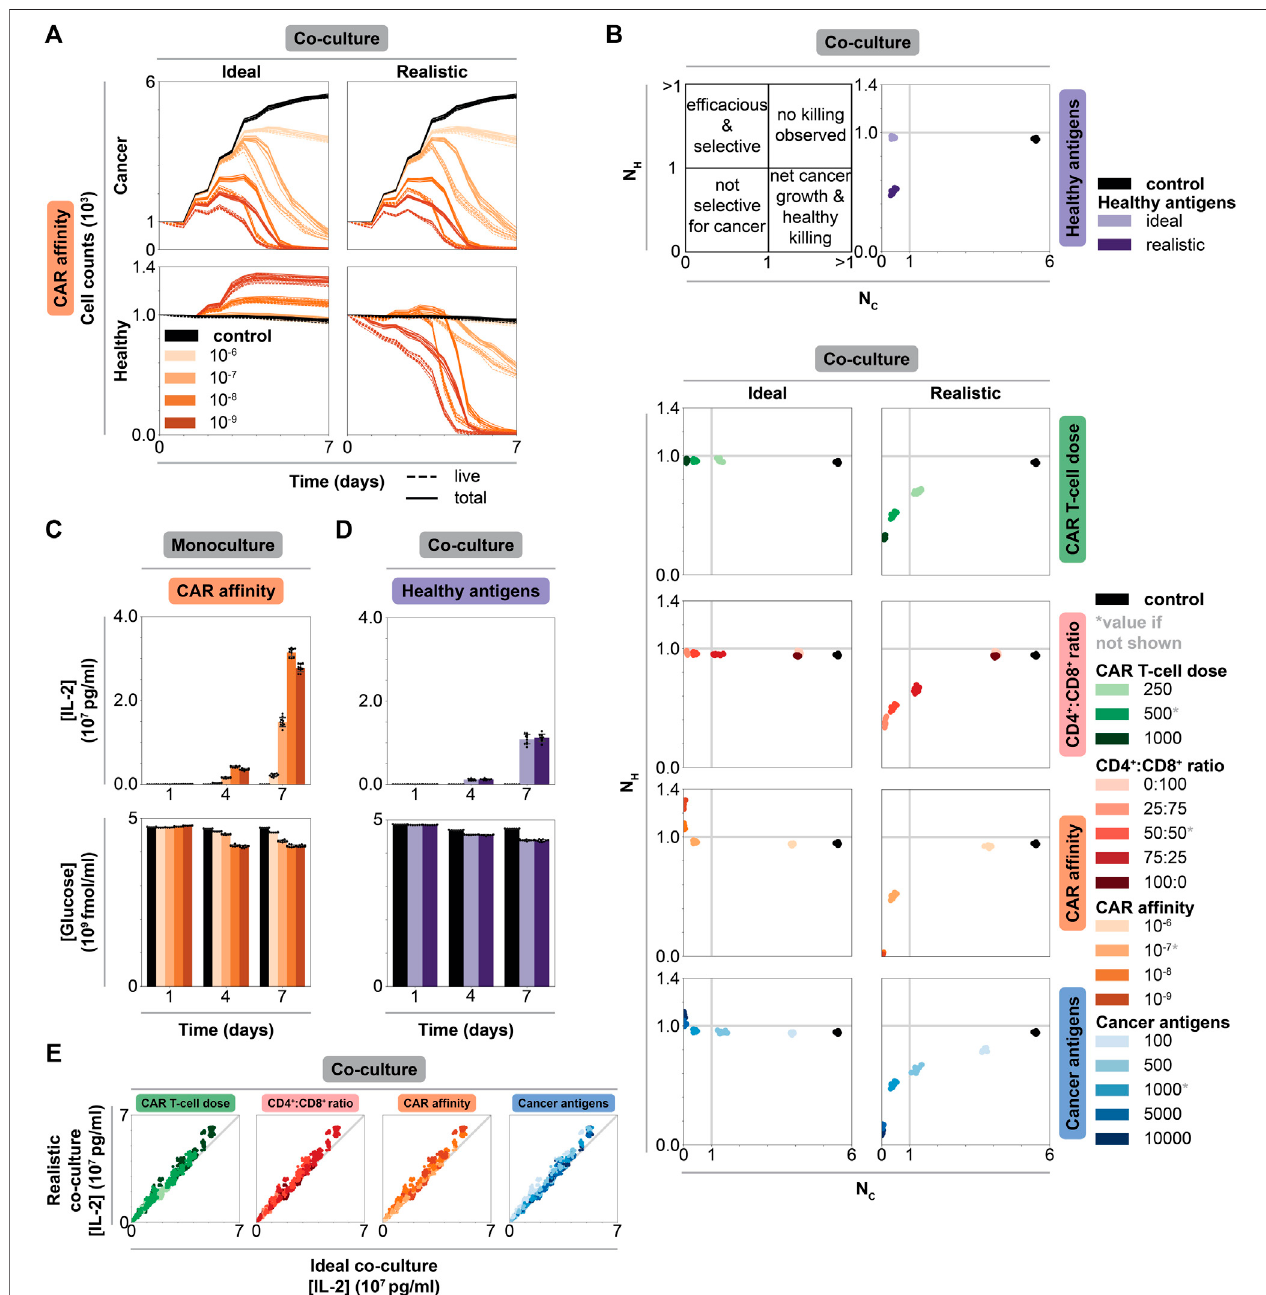
FIGURE 3 | Impact of individual CAR T-cell and tumor features on ef fi cacy, selectivity, and cytokine production in monoculture vs co-culture. (A) Cancer and healthy cell counts over time of untreated (black) and treated (graded hues) conditions holding all but CAR af fi nity, which is reported in units of M, constant at an intermediate value and separating data by co-culture context. Column shows co-culture type, row shows cell type. Solid lines represent total cell counts, dashed lines represent live cell counts (live, excludes necrotic and apoptotic states as in Figure 2 ). Intermediate values of other features indicated by asterisk in panel B: CAR T-cell dose = 500 CAR T-cells, CD4 + :CD8 + ratio = 50:50, cancer antigens = 1000 antigens/cell. (B) Scatter plots of normalized live healthy cell count ( N H ) vs normalized live cancer cell count ( N C ) for untreated (black) and treated conditions (graded hues) holding all but one axis constant at an intermediate value. Upper left plot shows quadrant meanings. Upper right plot shows scatter plot for different co-culture contexts. Columns show co-culture type, and each row indicates which feature is being plotted. (C) IL-2 and glucose concentrations over time holding all but CAR af fi nity constant at an intermediate value in monoculture. Legend is consistent with panel B. (D) IL-2 and glucose concentrations over time varying CAR af fi nity while holding all features constant at an intermediate value in ideal and realistic co-culture. Legend is consistent with panel B. (E) Parity plot of IL-2 concentration at fi nal time point (t = 7 d) for all conditions in realistic ( y -axis) vs ideal ( x -axis) co-culture colored by each feature (column). Legend is consistent with panel